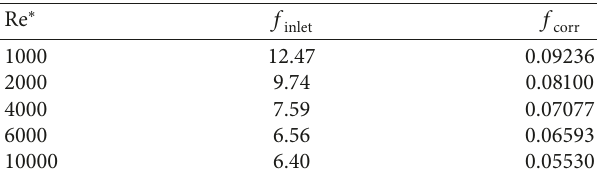
Table 2: Fanning friction factor for plates P1–P4 with LL corru- gated field in turbulent